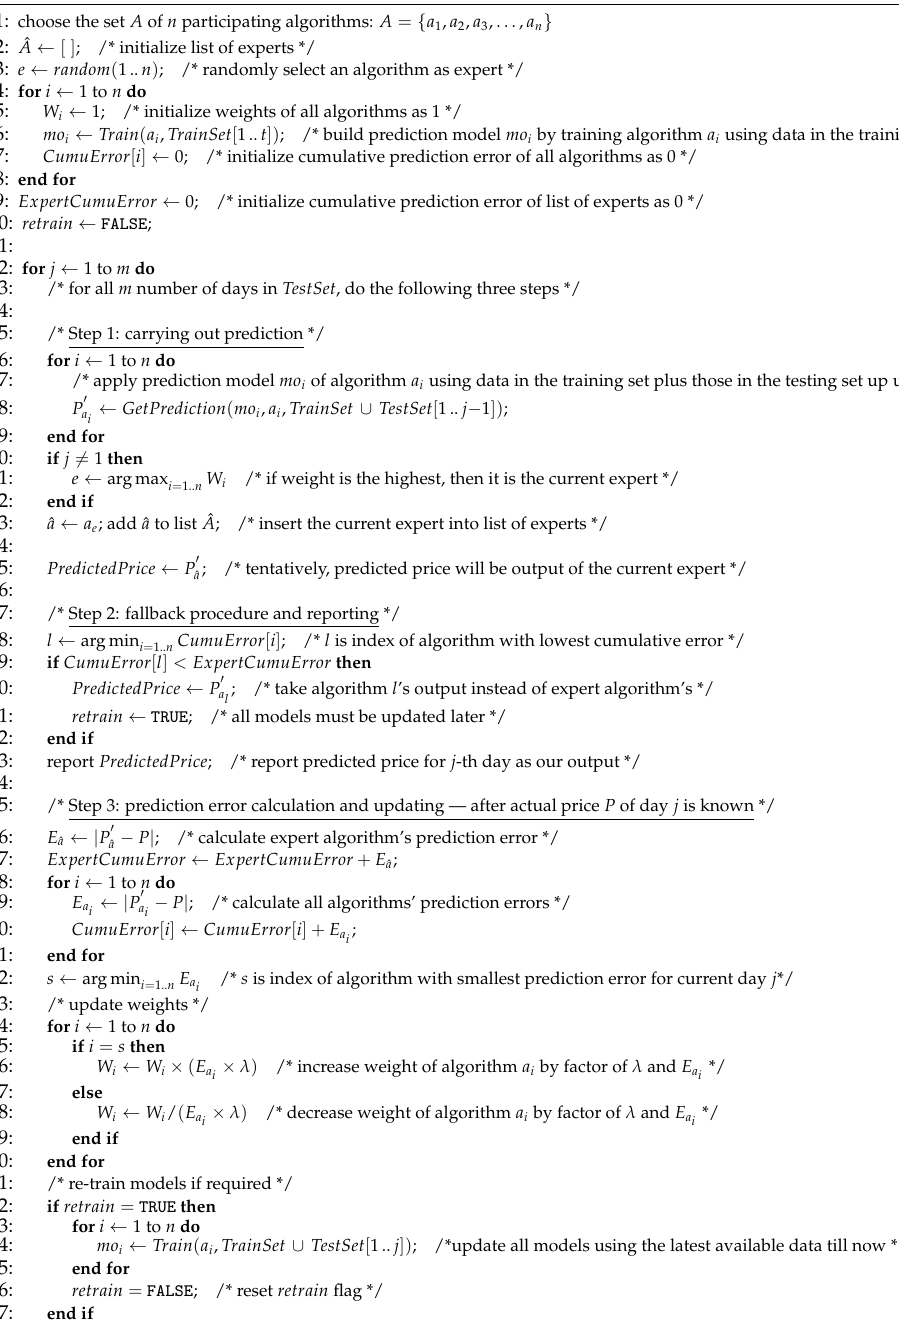
Algorithm 2 Varying weight method ( TrainSet [ 1 .. t ] , TestSet [ 1 .. m ] , λ